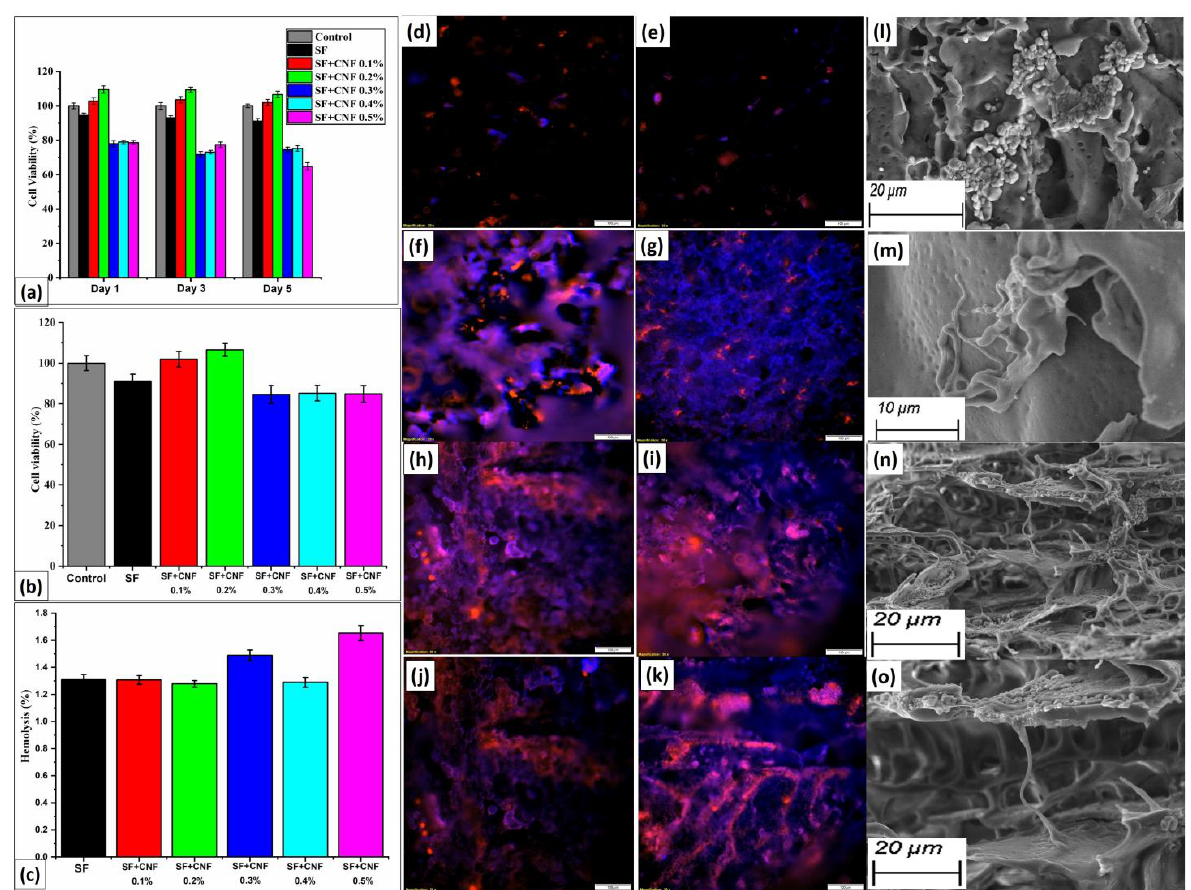
Figure 9. ( a ) Percentage of skin cells viability for samples with different CNF densities in the SF; ( b ) Percentage of blood cells viability for samples with different CNF densities in the SF; ( c ) Percentage of hemolysis for samples with different CNF densities in the SF; Cytotoxicity studies of: ( d ) the pure SF; ( e ) the SF with CNF density equal to 0.1%; ( f ) the SF with CNF density equal to 0.2%; ( g ) the SF with CNF density equal to 0.3%; ( h ) the SF with CNF density equal to 0.4%; ( i ) the SF with CNF density equal to 0.5%; ( j ) the untapped SF with CNF density equal to 0.4%; ( k ) the tapped SF with CNF density equal to 0.4%; ( l ) untapped pure SF sample with cells; ( m ) tapped pure SF sample with cells; ( n ) untapped SF with 0.4% sample with cells; and ( o ) tapped SF with 0.4% sample with cells.